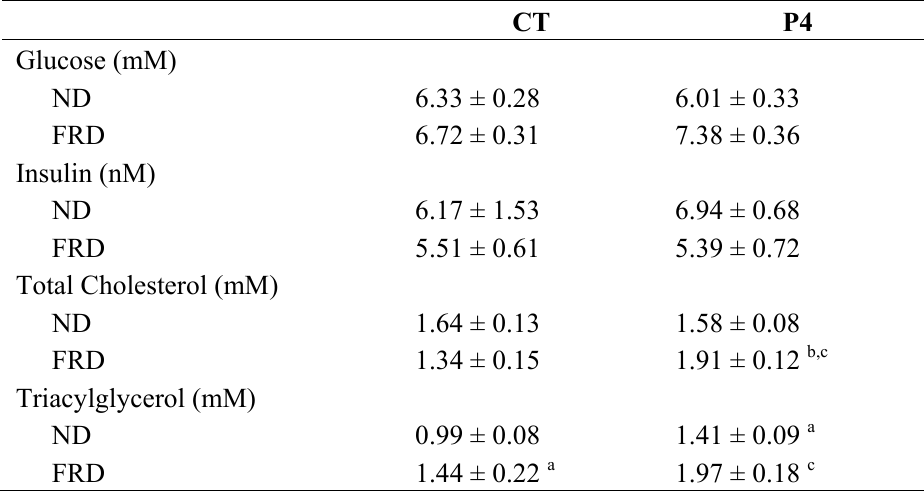
Table 2. Circulating levels of several metabolites in control (CT) and progesterone-primed (P4) rats examined 21 days after either ND or FRD intake. Values are means ± SEM, n = 6–7 rats per